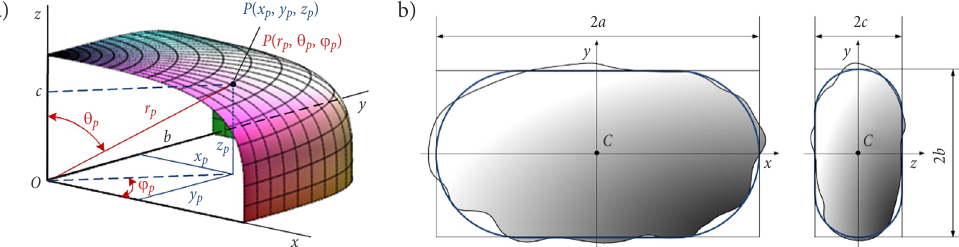
Fig. 1. Illustration of particle geometry: (a) modelling domain on the base of quadric image, (b) quasi-quadric particle in bounding